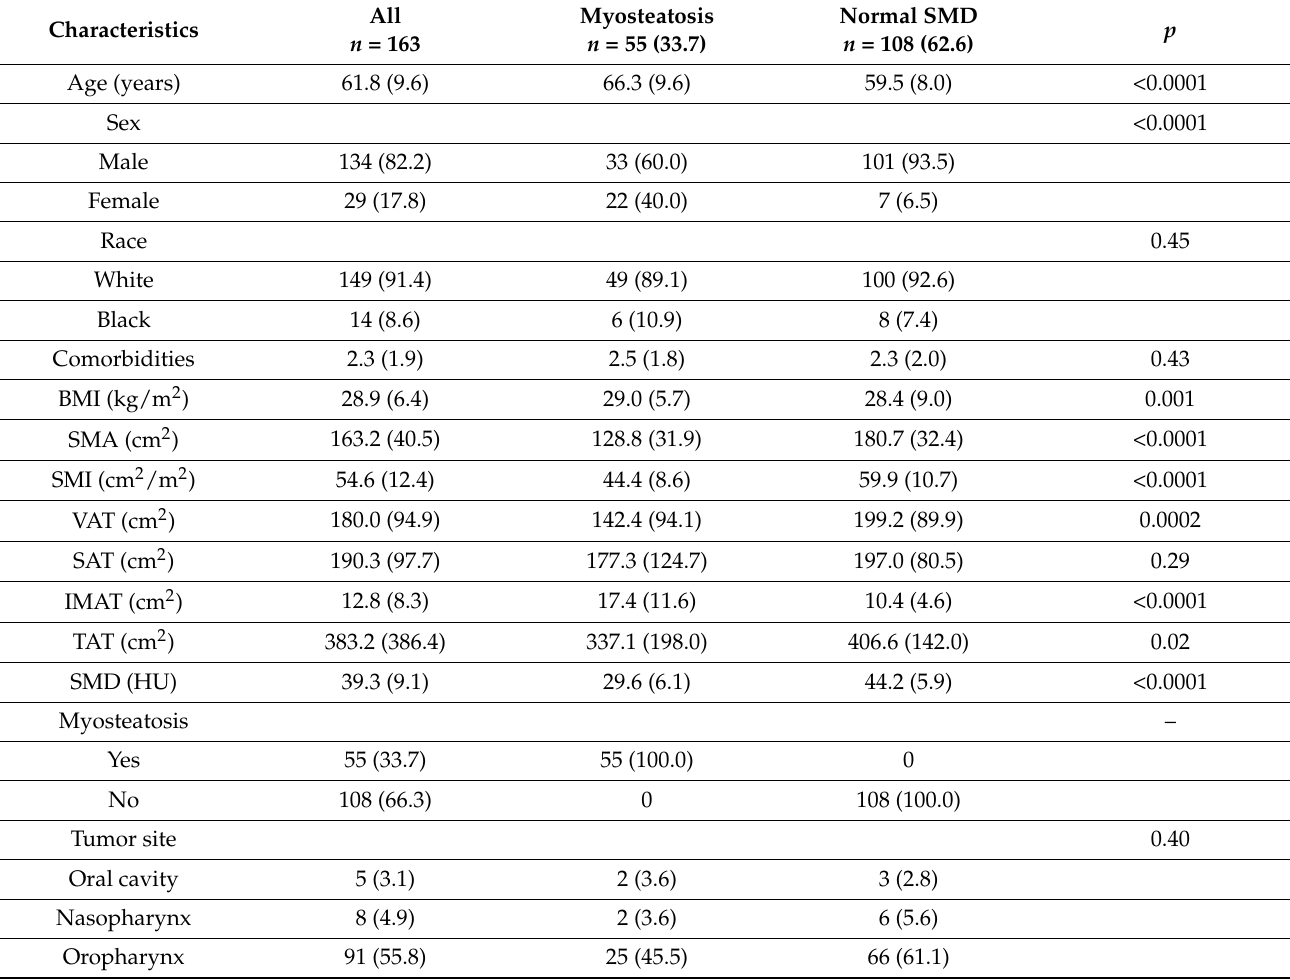
Table 1. Patient characteristics stratified by myosteatosis prior to